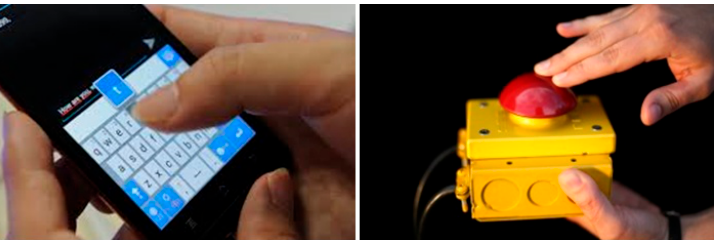
Figure 2. Examples of human input